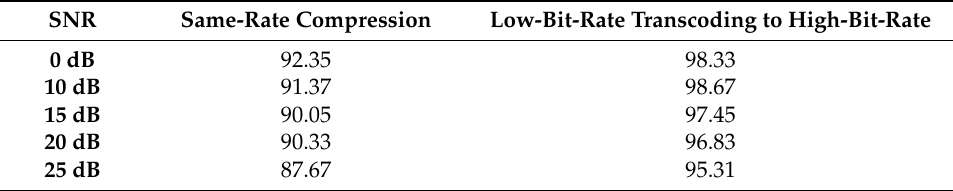
Table 10. AAC double compression detection accuracy under noise—FAAC